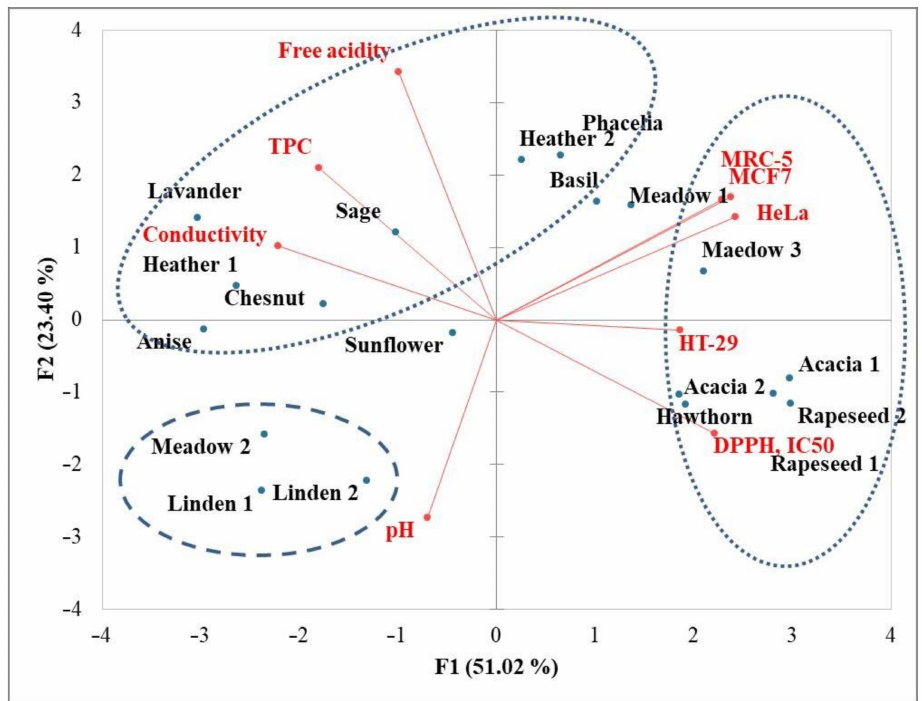
Figure 1. Principal component analysis (PCA) of physicochemical parameters and antioxidant and antiproliferative activities based on component correlations for the honey samples from the Western